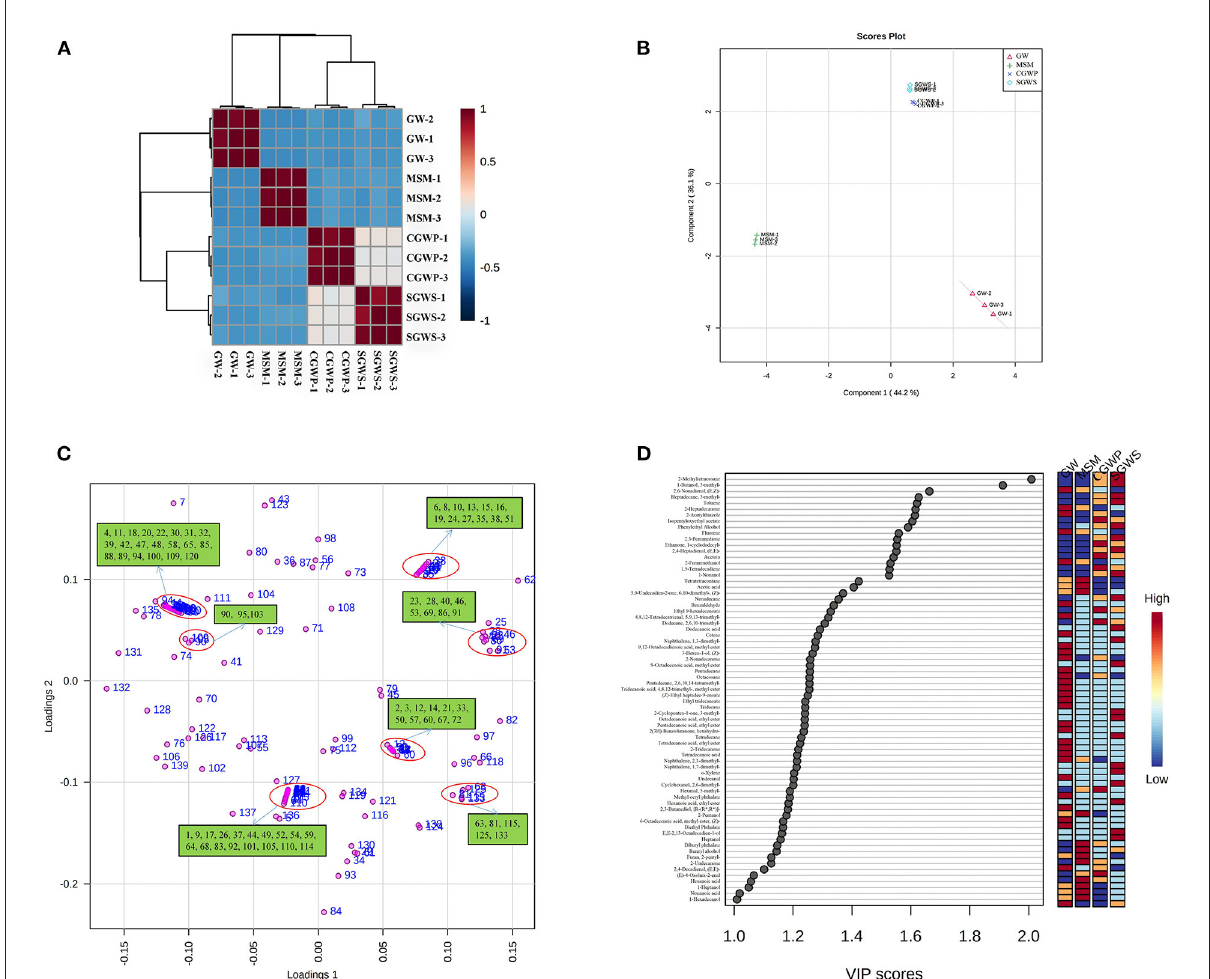
FIGURE6 PLS-DA of volatile compounds for nian zhuan in each processing stages. (A) correlation analysis of different processed samples. (B) scores scatter plot. (C) Loading plot. (D) Important volatiles (variable importance in projection (VIP) > 1.0). The colored on the right represents the relative concentrations of the corresponding volatile compounds at different stages. The number in the (C) corresponds to a volatile compound (Supplementary Table